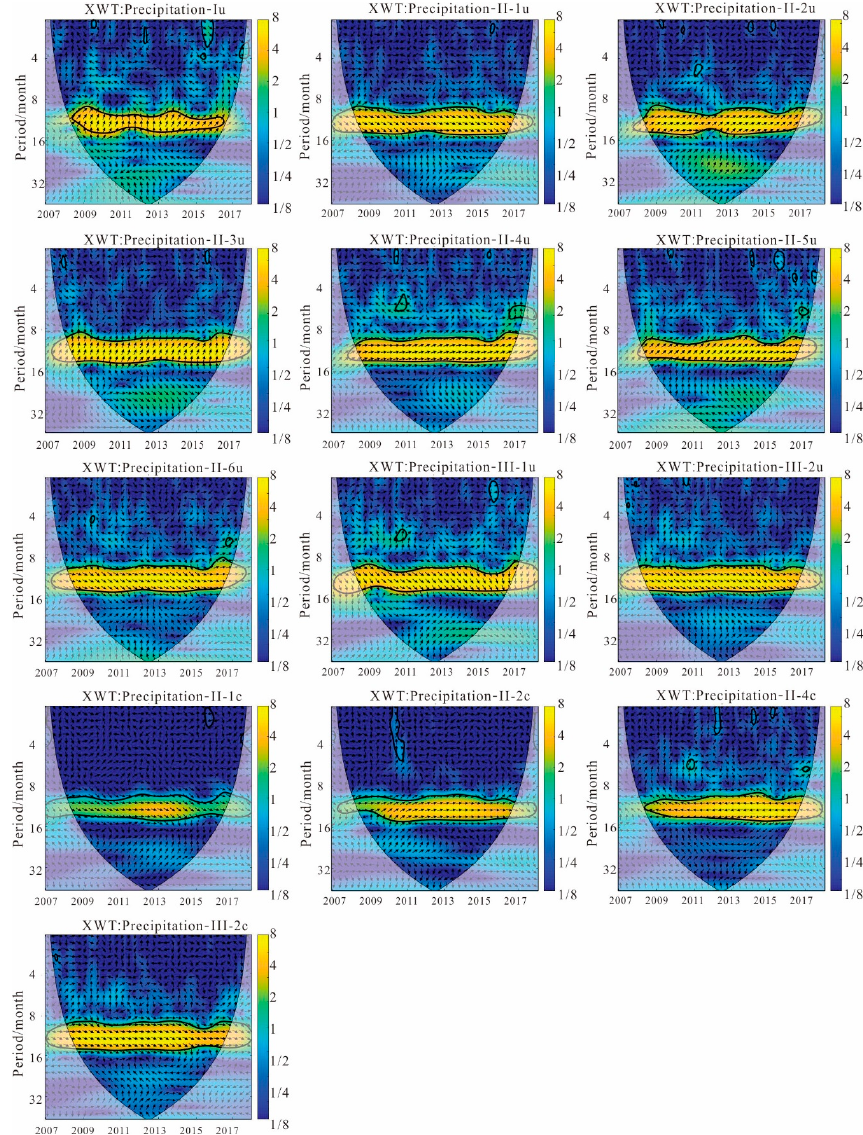
Figure 13. XWT (Cross Wavelet Transform) analysis of precipitation and groundwater depth in different hydrogeological zones. The precipitation-Iu, precipitation-II-1u, precipitation-II-2u, precipitation-II-3u, precipitation-II-4u, precipitation-II-5u, precipitation-II-6u, precipitation-III-1u, and precipitation-III-2u subgraphs show the results of XWT analysis of precipitation and groundwater depth of the unconfined aquifer in the I, II-1, II-2, II-3, II-4, II-5, II-6, III-1, and III-2 hydrogeological zones. The precipitation-II-1c, precipitation-II-2c, precipitation-II-4c, and precipitation-III-2c subgraphs show the results of XWT analysis of precipitation and groundwater depth of the confined aquifer in the II-1, II-2, II-4, and III-2 hydrogeological zones. WTC is another tool for discovering the coherence of cross-wavelet power in time–frequency space. Even if the corresponding region of the low energy value of the XWT power spectrum is small, the correlation in the wave coherence spectrum may be significant. The results of WTC analysis (Figure 14) showed that the subsequent period of the unconfined water response to precipitation in